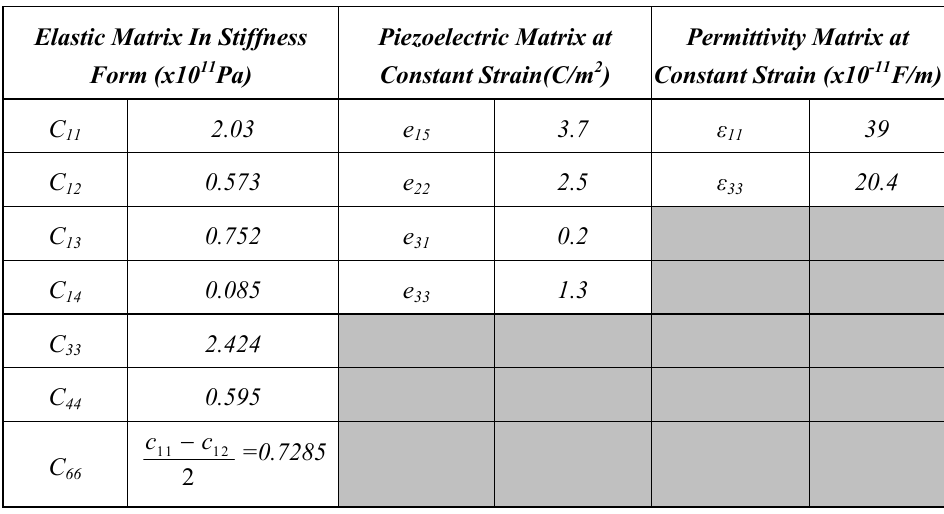
Table 1. Material Properties for lithium niobate.